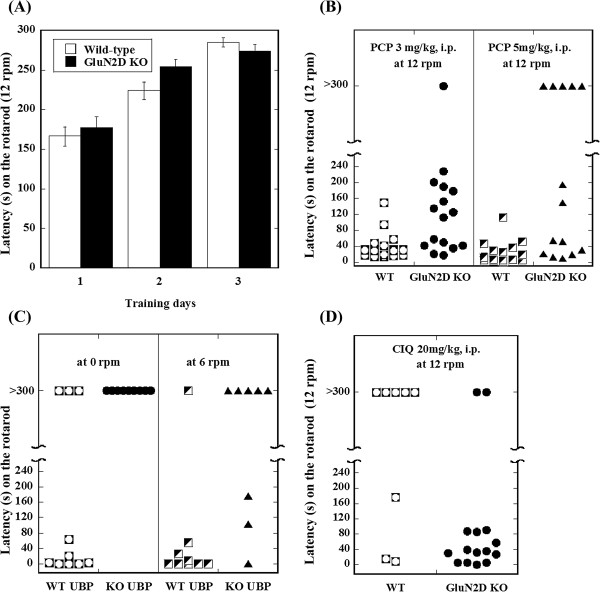
The effects of PCP, UBP, and CIQ on motor performance. (A) Wildtype mice and KO mice did not display significant differences in motor learning. WT, wildtype mice (n = 60); KO, GluN2D knockout mice (n = 55). (B) Ataxic effects of phencyclidine (PCP) at 3.0 mg/kg (n = 15 WT, n = 17 KO) and 5.0 mg/kg (n = 16 WT, n = 15 KO) in the rotarod test at 12 rpm. A significant effect of genotype was observed in the PCP-induced decrease in time at the two doses tested (p < 0.05 at both doses, dependence on genotype; Fisher’s exact test). Twenty-four to 72 h after PCP injection, the WT and KO mice were injected with saline. Motor performance was not affected by saline injection. Almost all of the mice showed maximal performance at 12 rpm (> 300 s), and the remaining mice showed normal performance (> 200 s). (C) Effect of UBP in the rotarod test at 0 rpm (n = 10 WT, n = 9 KO) and 6 rpm (n = 9 WT, n = 8 KO). The differences between WT and GluN2D KO mice in UBP141-induced motor impairment were significant at 0 and 6 rpm (p < 0.05 at both speeds, dependence on genotype; Fisher’s exact test). The vehicle injection did not affect motor performances in WT and KO mice (both genotypes: > 300 s at 12 rpm, n = 5; > 200 s at 12 rpm, n = 2; < 200 s at 12 rpm, n = 1). (D) Effect of CIQ in the rotarod test at 12 rpm (n = 8 WT, n = 15 KO). The difference between WT and GluN2D KO mice in CIQ-induced motor impairment was significant (p < 0.05, dependence on genotype; Fisher’s exact test). The vehicle injection did not affect motor performances in WT and KO mice (WT: > 300 s at 12 rpm, n = 5; > 200 s at 12 rpm, n = 2; KO: > 300 s at 12 rpm, n = 11; > 200 s at 12 rpm, n = 2).